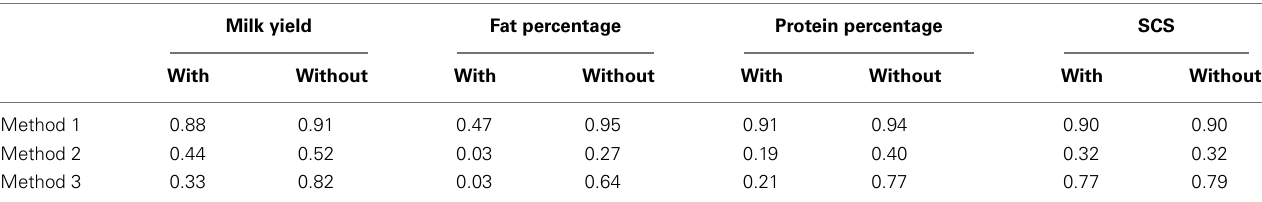
Table 4 | Coefficients of determination ( R 2 ) of regressions of proportion of variance on physical length of each chromosome, including and excluding BTA14 from the analyses. Milk yield Fat percentage Protein percentage SCS With Without With Without With Without